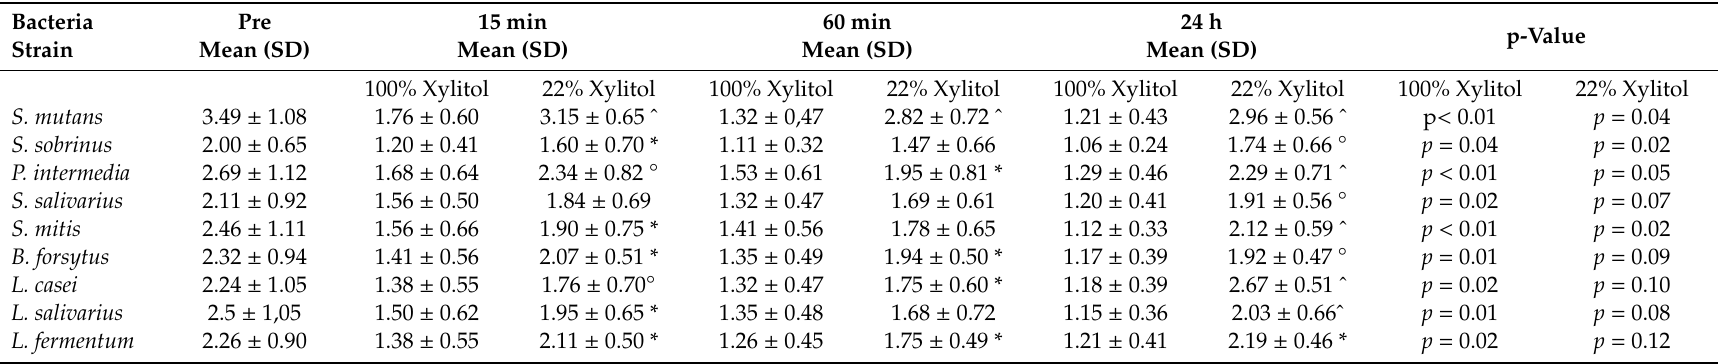
Table 3. Mean concentration ( ± SD) of bacteria in sub-gingival plaque based on analysis of a 5-unit score. (1 = < 10 5 , 2 = 10 5 , 3 = 10 5 > x < 10 6 , 4 = 10 6 , 5 = > 10 6 ). Bacteria